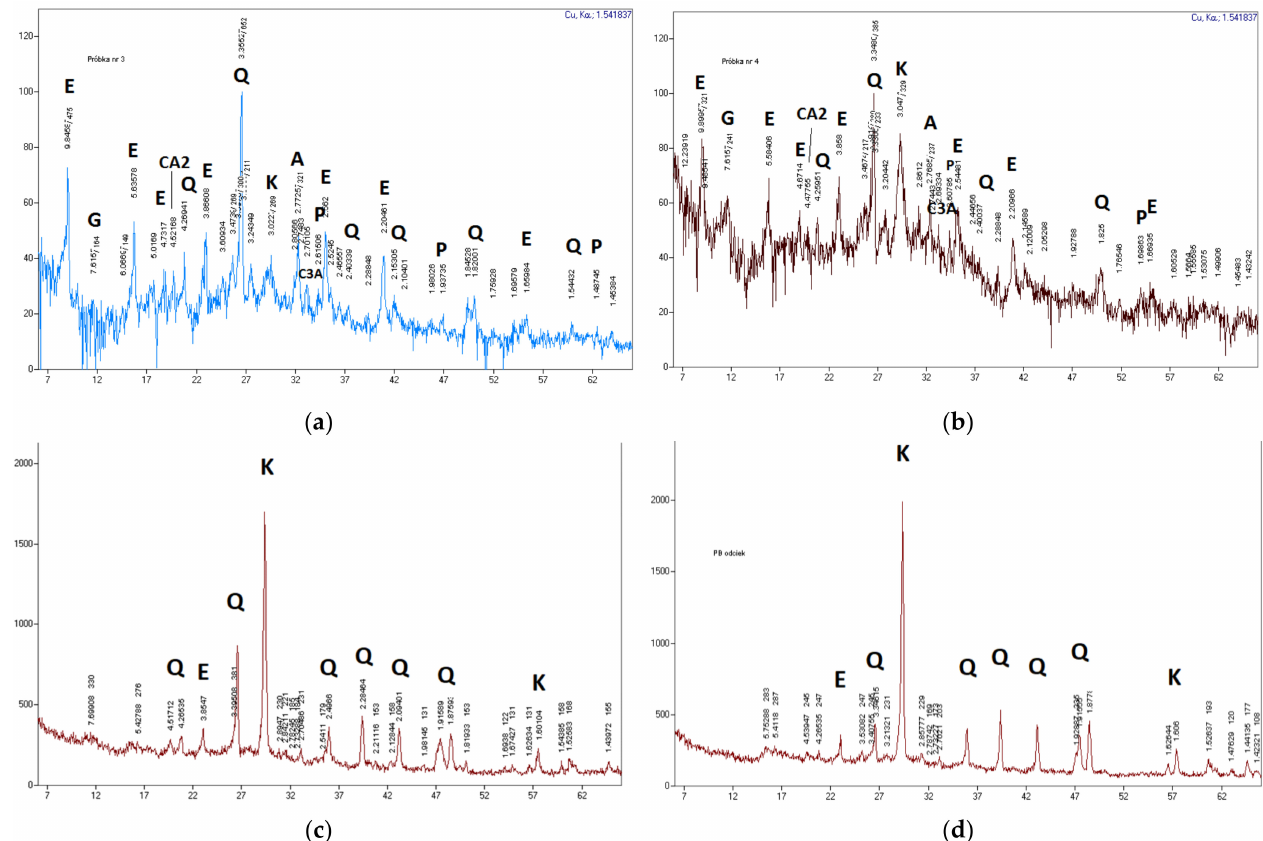
Figure 3. Diffraction patterns (XRD) of hardening slurry specimens A and B: ( a ) slurry A after tap water filtration; ( b ) slurry B after tap water filtration; ( c ) slurry A after landfill eluate filtration; ( d ) slurry B after landfill eluate filtration. Designations: A—alite, C3A—tricalcium aluminate, CA2—grossite, E—ettringite, K—calcite, Q—quartz, P—portlandite,